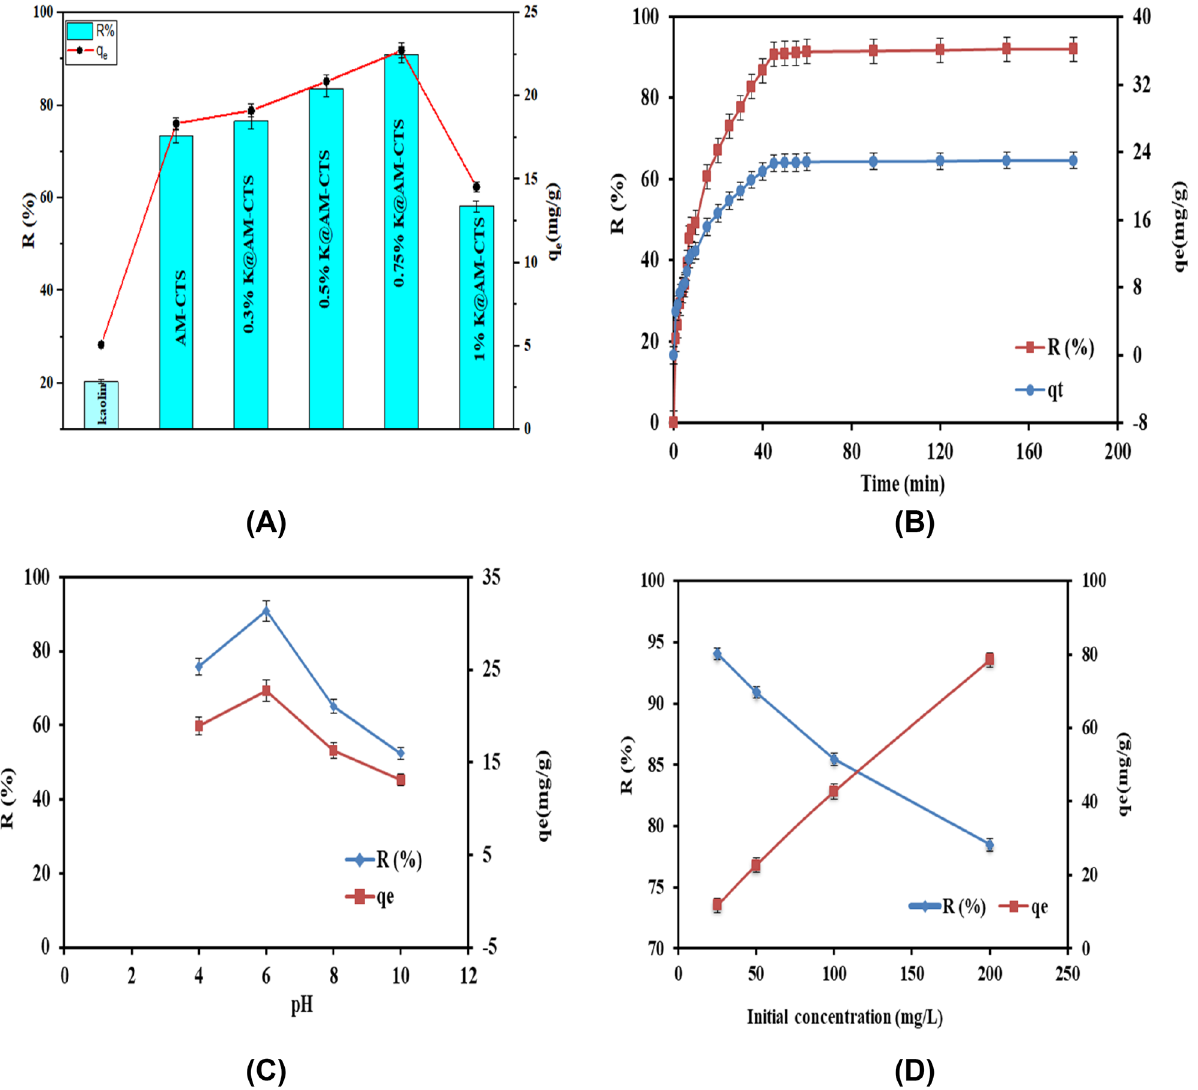
Figure 6. Impacts of ( A ) Kaolin ratio, ( B ) contact time, ( C ) pH and ( D ) initial concentration of CR